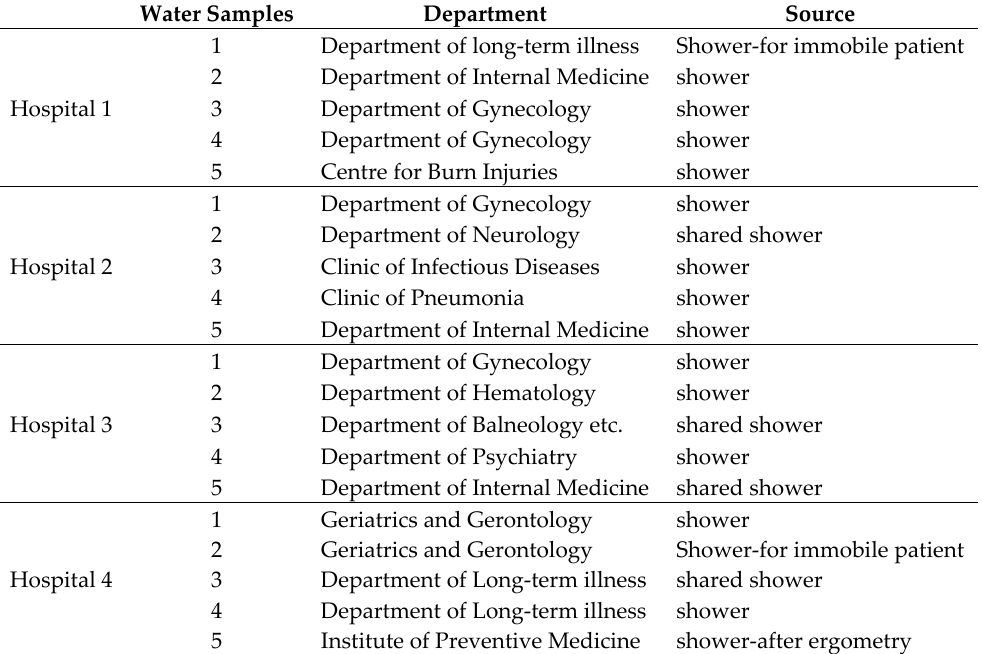
Table 1. Water samples of potable hot water in selected hospitals.